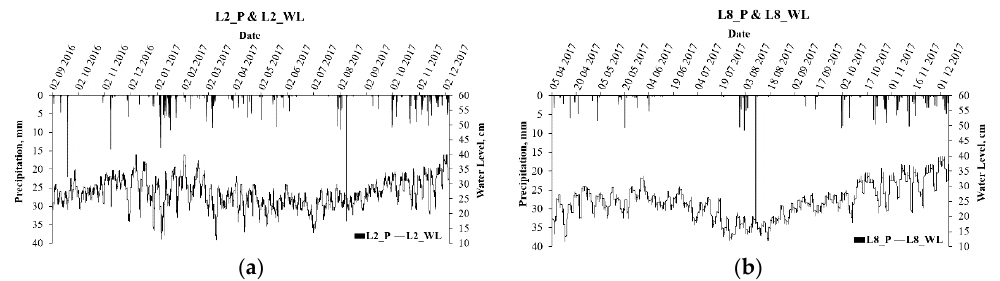
Figure 6. ( a ) L2 spring water level data; ( b ) L8 spring water level data.